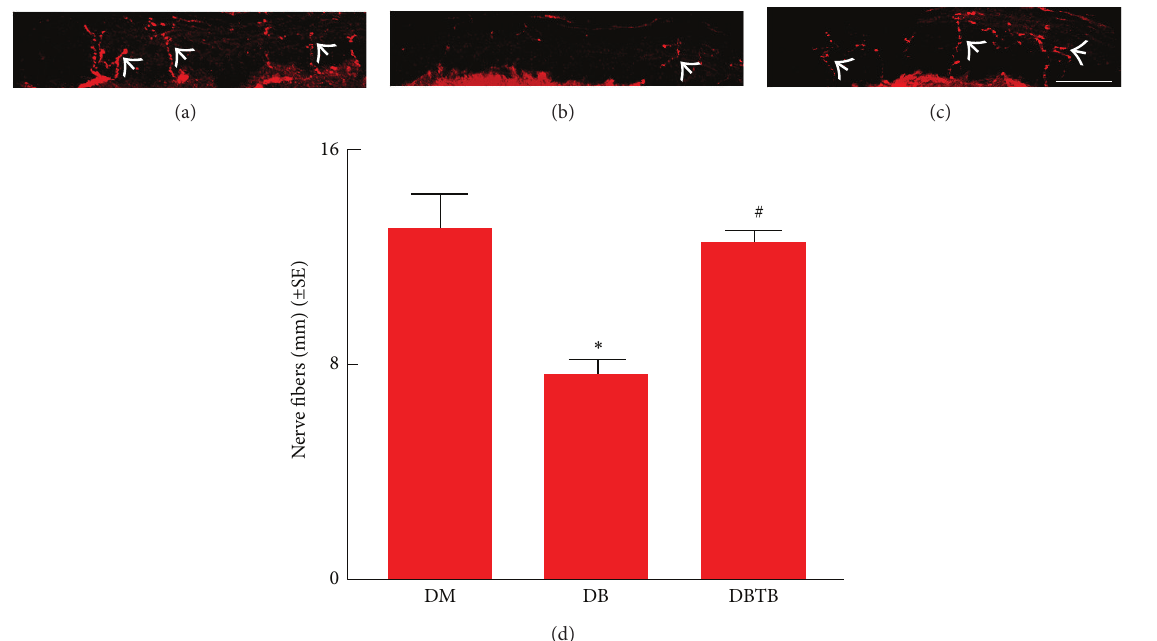
Figure 2: Effect of T 𝛽 4 on the intraepidermal nerve fiber in diabetic mice. Panels (a) to (c) show PGP 9.5 immunoreactive fibers (arrows) in the plantar skin from a representative nondiabetic mouse (a), diabetic mouse treated with saline (b), and diabetic mouse treated with T 𝛽 4 (c) 16 weeks after treatment. Panel (d) is quantitative data. Bar = 50 𝜇 m. ∗ 𝑃 < 0.05 versus the nondiabetic group (DM), # 𝑃 < 0.05 versus diabetic mice treated with saline (DB). 𝑛 = 10 /group.